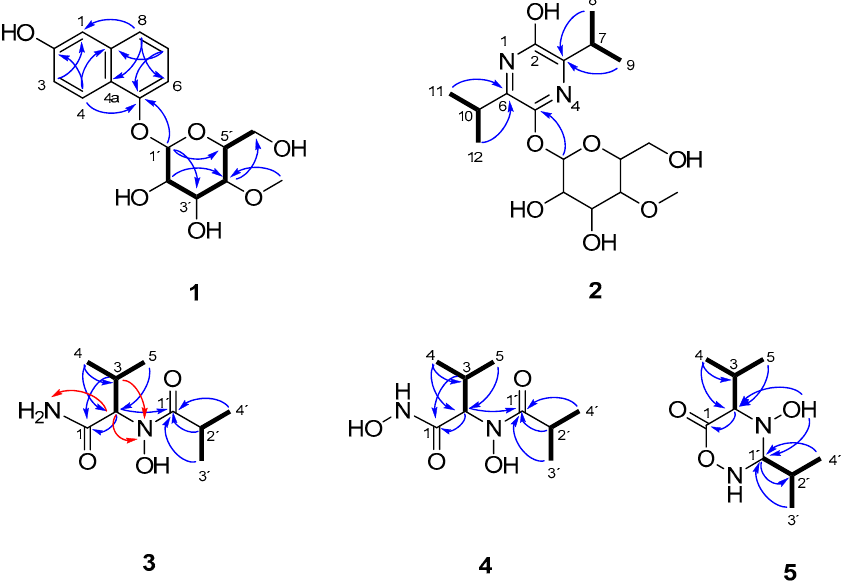
Figure 2. Key COSY (bold bonds), 13 C-HMBC (blue arrows), and 15 N-HMBC (red arrows) correlations for Compounds 1 – 5 .